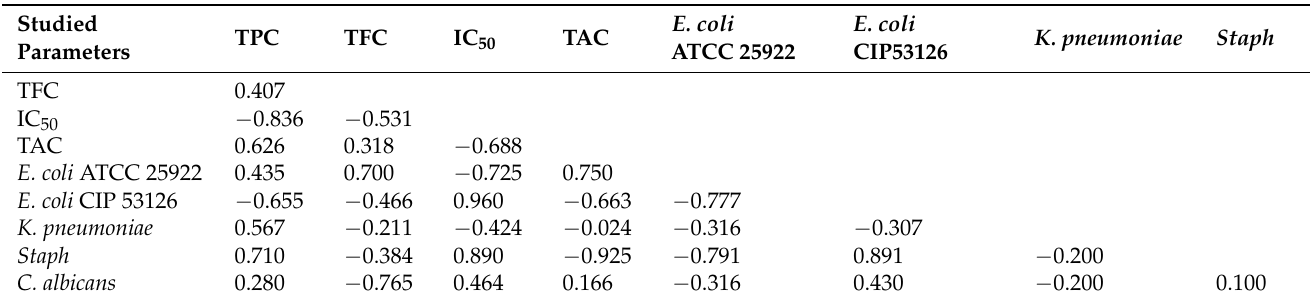
Table 6. Pearson coefficients of correlation between C. humilis